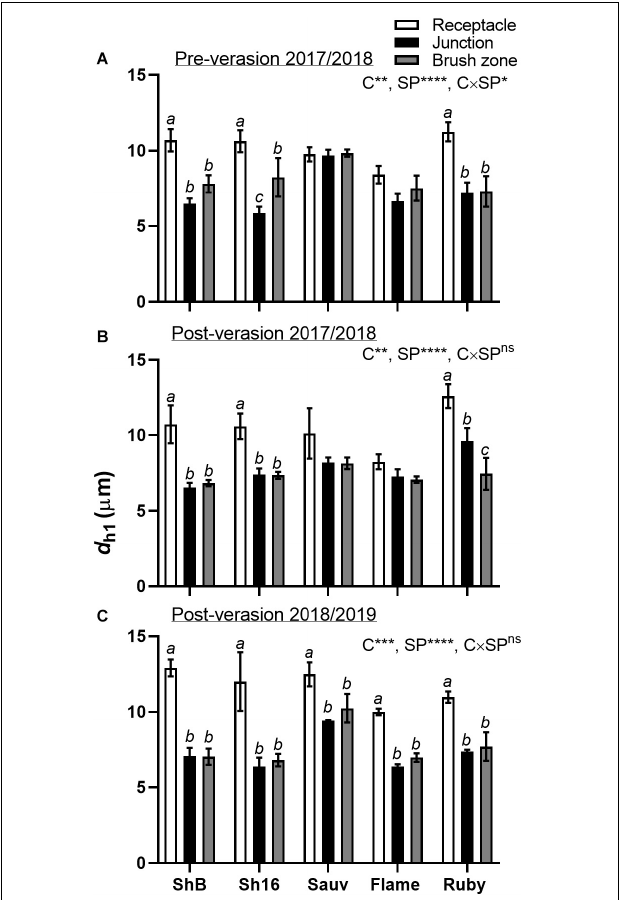
FIGURE 9 | Mean hydraulically weighted diameter ( d h 1 , µ m) of xylem vessels in the receptacle (white bars), receptacle/berry junction (black bars) and brush zone (gray bars) of Shiraz BVRC12 (ShB), Shiraz 1654 (Sh16), Sauvignon Blanc (Sauv), Flame Seedless (Flame), and Ruby Seedless (Ruby) before (A) and after (B) veraison in the 2017/2018 season and after veraison in the 2018/2019 season (C) (data of brush zone 2 was used for Post-veraison 2018/2019). Data are presented as mean ± s.e.m. ( n = 3 or 4). The ANOVA results are given for cultivar (C), section position (SP) and cultivar × section positon (C × SP) interaction. Levels of significance are * P < 0.05, ** P < 0.01, *** P < 0.001, **** P < 0.0001 and ns , not significant. Where different lower-case letters are shown, it indicates differences between section positions within each cultivar (Fisher’s LSD test, P < 0.05).